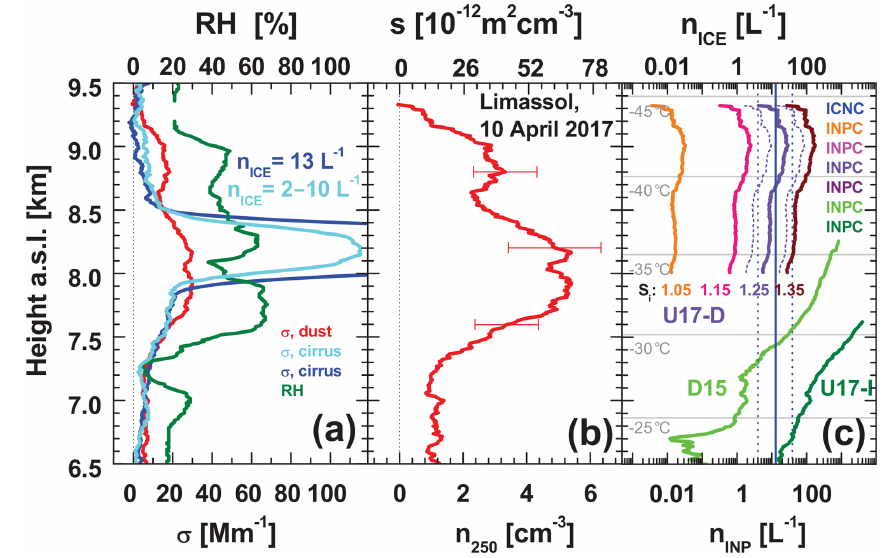
Figure 9. Cirrus INPC–ICNC closure study based on LACROS observations at Limassol, Cyprus, on 10 April 2017 (see Fig. 7) during Cy- CARE. (a) Dust extinction coefficient (06:10–06:30UTC mean), ice crystal extinction coefficient (light blue, 06:35–06:42UTC mean; blue, 06:48–06:57UTC mean; cirrus from 8 to 8.5km height), relative humidity (RH, radiosonde, launch at 05:50UTC), estimated ICNC ( n I CE ; light blue for the 06:35–06:42UTC time period; blue for the 06:58–07:05UTC time period), (b) dust particle number concentration n 250 , d (considering large particles with a radius of > 250nm only) and surface area concentration s d (06:10–6:30UTC mean values), and (c) INPC ( n INP , 06:10–6:30UTC mean) determined by using the deposition nucleation U17-D(d) parameterization for four different ice supersatura- tion values ( S i from 1.05 to 1.35). The uncertainty range of each of the four deposition nucleation INPC profiles is indicated for S i = 1 . 10. For comparison, also immersion freezing INPC profiles estimated by using the U17-I(d) (dark green) and D15 INP parameterizations (green, see Table 1) are shown. The ICNC value of 13L − 1 (see the number in a ) is shown as the vertical blue line with the uncertainty range as the vertical blue dashed